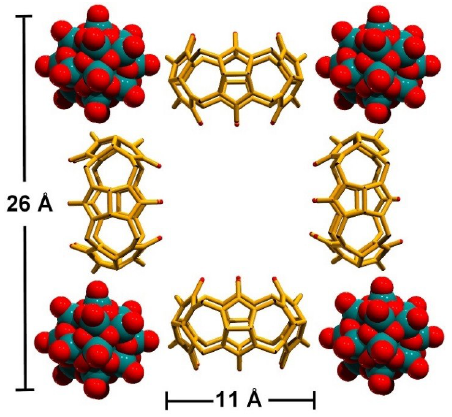
Figure 6. Representation of intermolecular interactions between the {V 18 } and cucurbit[n]uril molecules forming a 1D square shaped channel.